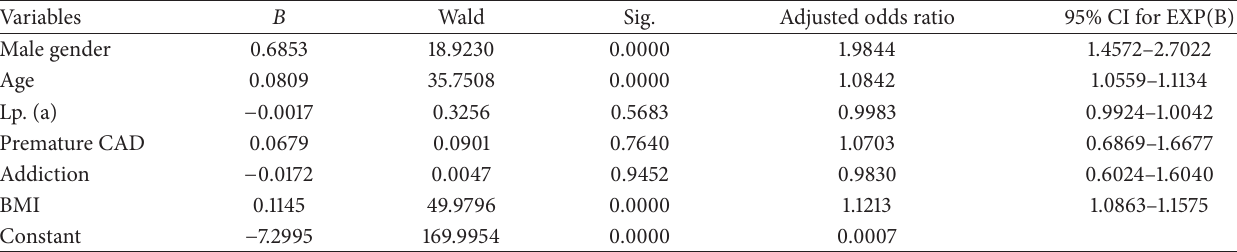
Table 6: Multiple logistic regression analysis using metabolic syndrome as dependent